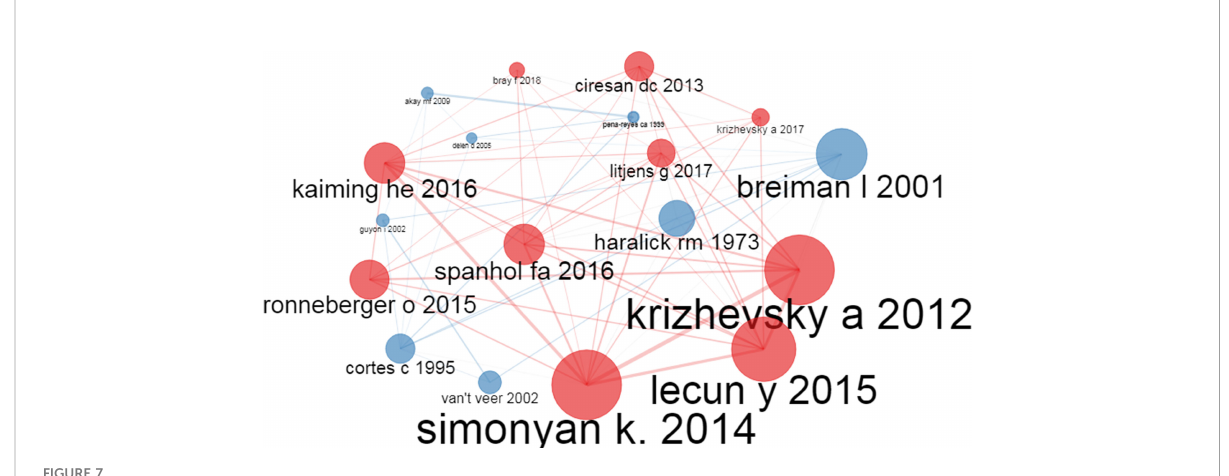
FIGURE 7 A co-citation network graph of